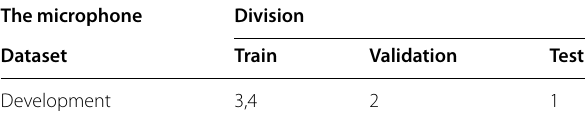
Table 2 Dataset partitioning settings The microphone